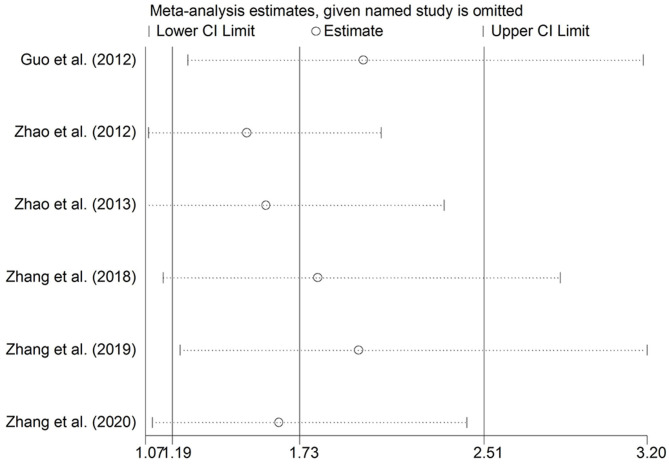
Sensitivity analysis through the deletion of each study to reflect the individual influence on the calculated ORs in a heterozygous genetic model of MTHFR C677T polymorphism.